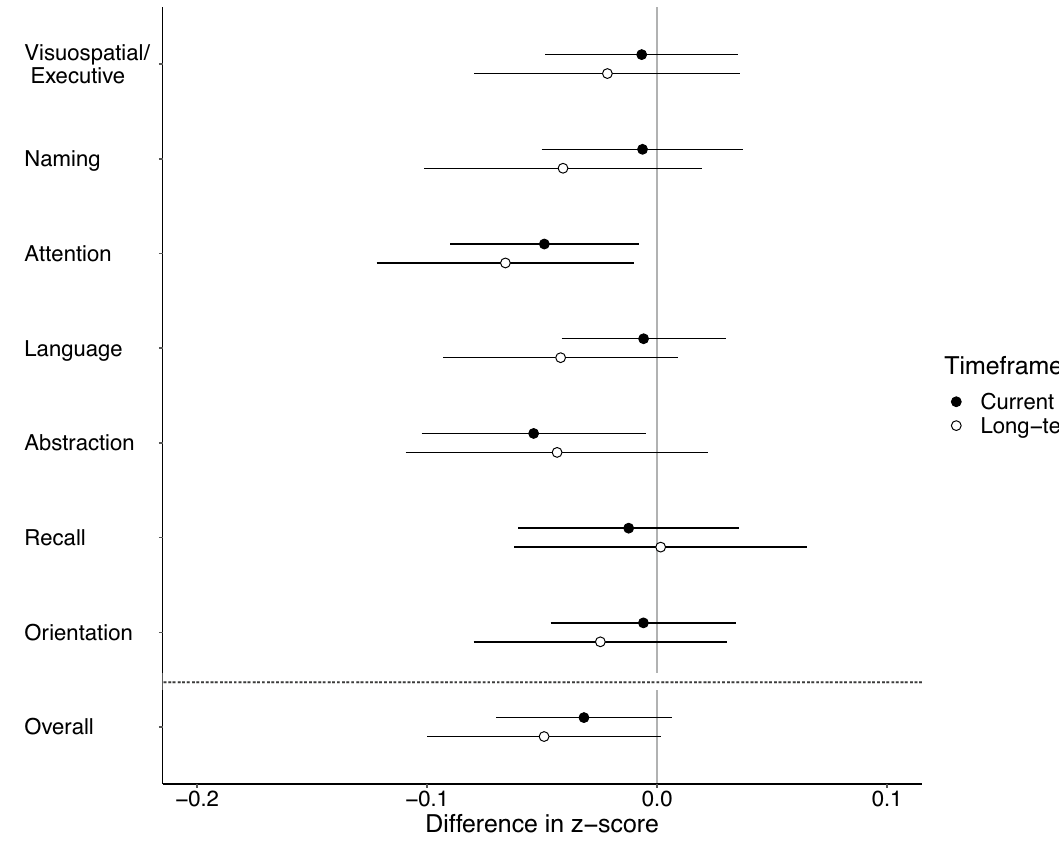
Figure 3. Associations between measures of cognitive function and intensity of indoor solid fuel use in peri- urban northern Chinese adults. Analyses were performed based on the data of 400 participants for intensity of indoor solid fuel use in the year prior to survey and 394 participants for intensity of indoor solid fuel use cumulatively over the past 20 years. Results from multivariable regression models. Difference in z-score represents the difference in cognitive score associated with a 100-day increase in solid fuel stove-use days in the past year (current; black circles) or a 5-year increase in solid fuel stove-use years over the past 20 years (long- term; white circles). Data are presented as point estimates of effects (central dots of the error bar) with 95% CIs (corresponding solid lines). The vertical solid line is the reference line. The horizontal dashed line separates estimate for overall cognition from estimates for cognitive domains. For detailed estimates of univariable and multivariable regression models, please see Supplementary Table